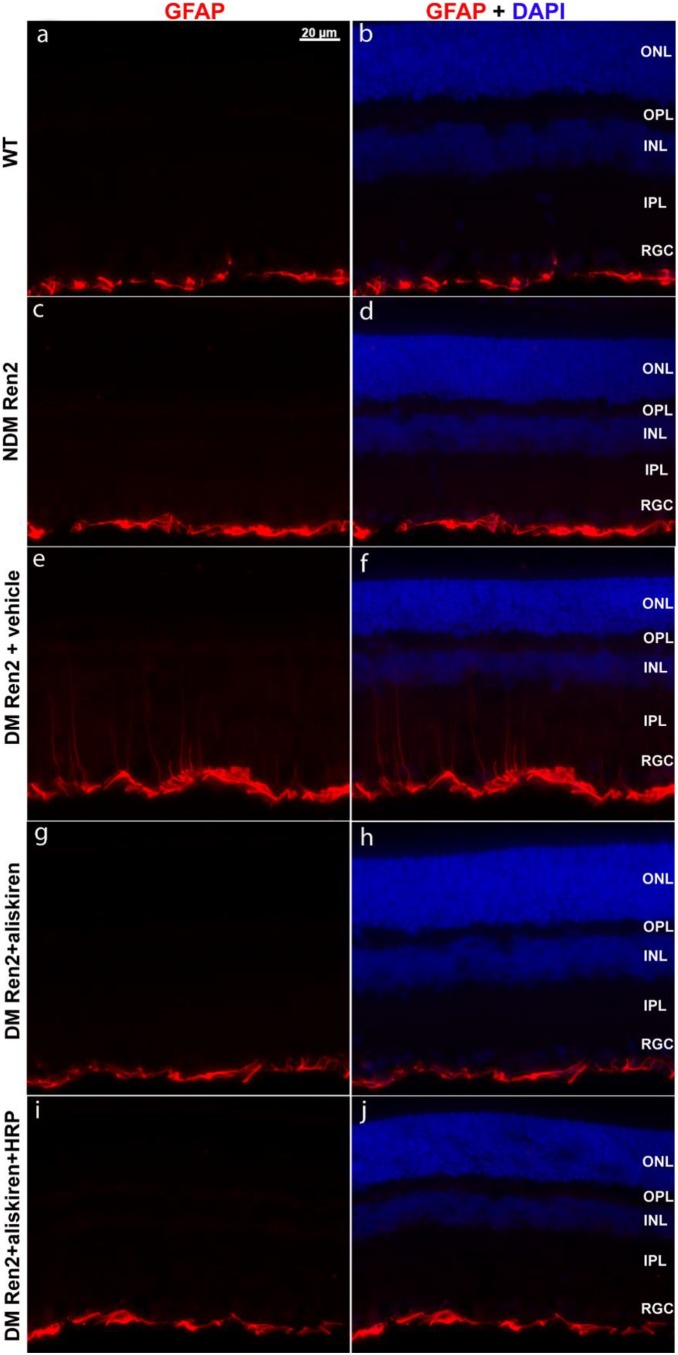
Immunofluorescence detection of GFAP expression in the retinas of wildtype (WT) Sprague–Dawley rats, non-diabetic (NDM) Ren2, diabetic (DM) Ren2 rats treated with vehicle, aliskiren or aliskiren+HRP.ONL: outer nuclear layer; OPL: outer plexiform layer; INL: inner nuclear layer; IPL: inner plexiform layer; RGC: retinal ganglion cell layer.